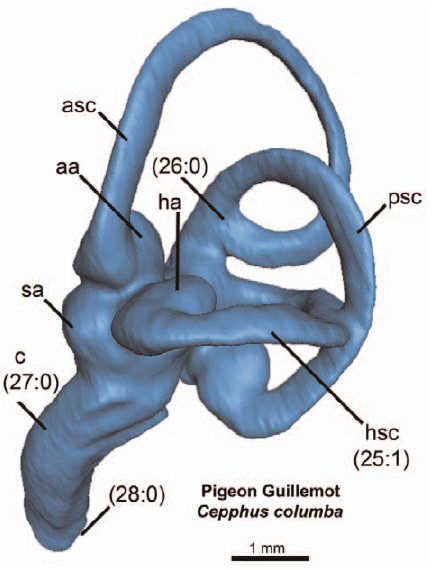
Figure 4. Left endosseous labyrinth of the Pigeon Guillemot Cepphuscolumba in lateral view. Numbers in parentheses represent character states from Appendix S1.